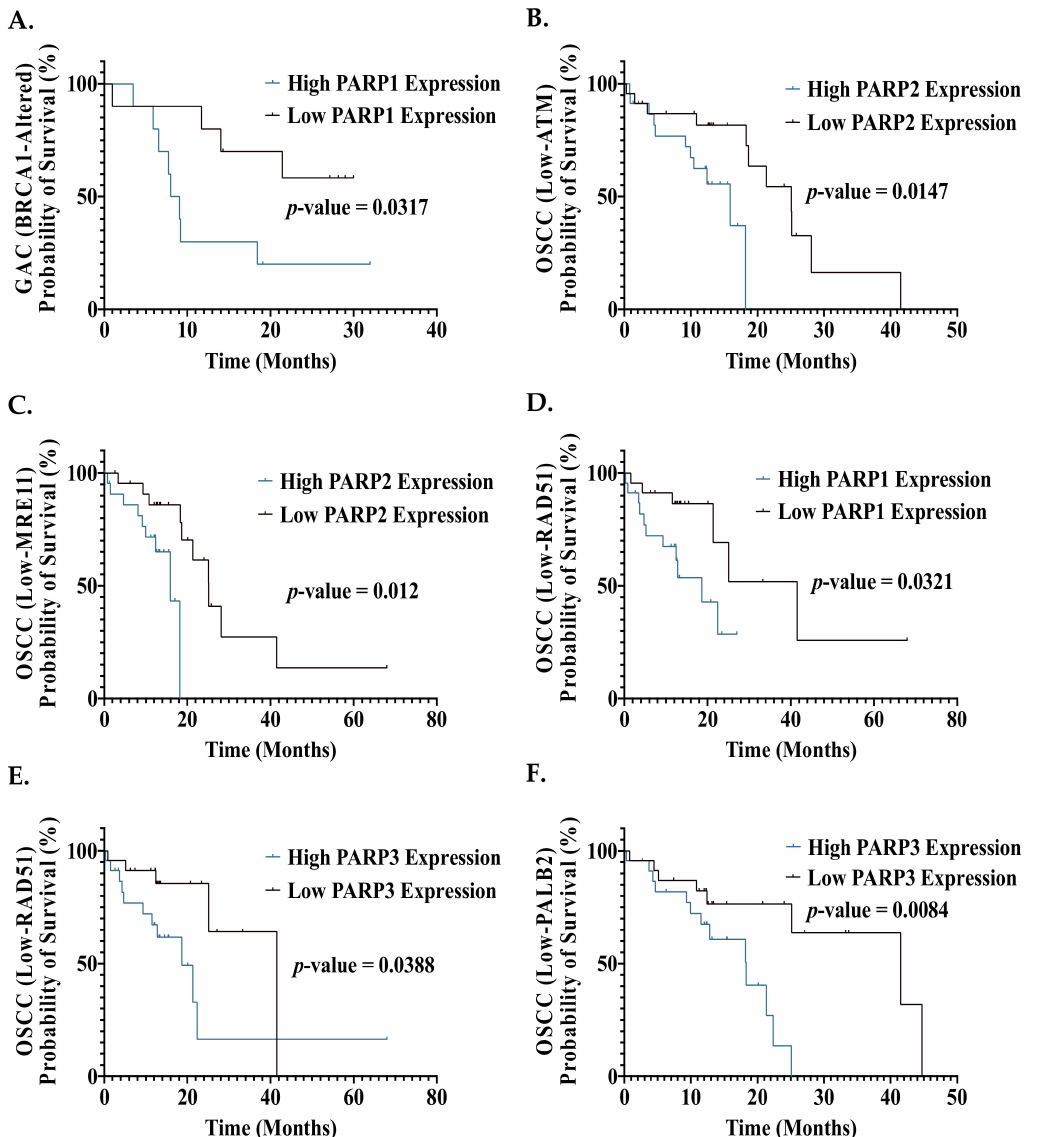
Figure 6. Effect of DDR PARP gene expression on overall survival outcomes of GI cancer patients with altered HR genes or low HR gene expression. ( A ) BRCA1-altered GAC patients with high PARP1 expression ( n = 11) have a significantly poorer OS, when compared to BRCA1-altered GAC patients with low PARP1 expression ( n = 11) (median OS of 8.5 months vs. undefined). ( B ) OSCC patients with low ATM and high PARP2 expression ( n = 23) have significantly poorer OS, when compared to OSCC patients with low ATM and low PARP2 expression ( n = 23) (median OS of 15.9 vs. 25.1 months). ( C ) OSCC patients with low MRE11 and high PARP2 expression ( n = 23) have significantly poorer OS, when compared to OSCC patients with low MRE11 and low PARP2 expression ( n = 23) (median OS of 15.9 vs. 25.1 months). ( D ) OSCC patients with low RAD51 and high PARP1 expression ( n = 23) have significantly poorer OS, when compared to OSCC patients with low RAD51 and low PARP1 expression ( n = 23) (median OS of 18.6 vs. 41.5 months). ( E ) OSCC patients with low RAD51 and high PARP3 expression ( n = 23) have significantly poorer OS, when compared to OSCC patients with low RAD51 and low PARP3 expression ( n = 23) (median OS of 18.6 vs. 41.5 months). ( F ) OSCC patients with low PALB2 and high PARP3 expression ( n = 23) have significantly poorer OS, when compared to OSCC patients with low PALB2 and low PARP3 expression ( n = 23) (median OS of 18.3 vs. 41.5 months). Statistical analysis was performed using a Kaplan–Meier survival analysis and log-rank (Mantel–Cox)